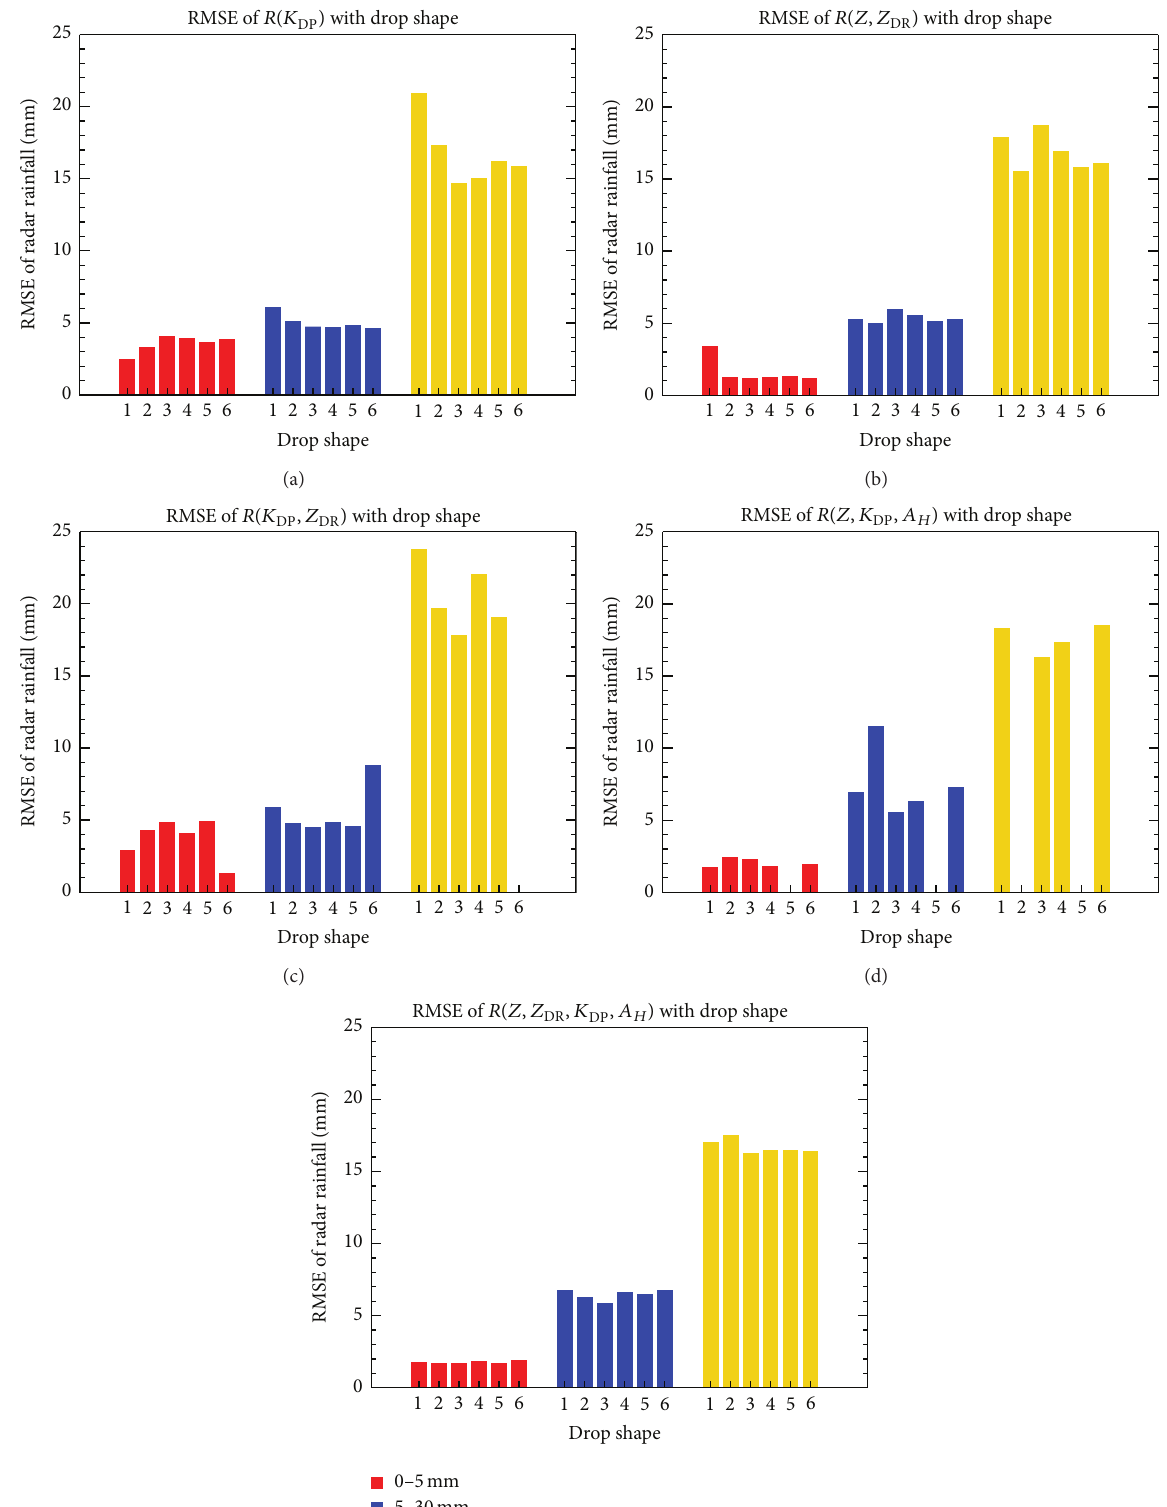
Figure 10: The RMSEs of (a) 𝑅(𝐾 DP ) , (b) 𝑅(𝑍, 𝑍 DP ) , (c) 𝑅(𝐾 DP , 𝑍 DP ) , (d) 𝑅(𝑍,𝐾 DP ,𝐴 𝐻 ) , and (e) 𝑅(𝑍, 𝑍 DP ,𝐾 DP ,𝐴 𝐻 ) with raindrop axis ratio relations in the three rainfall